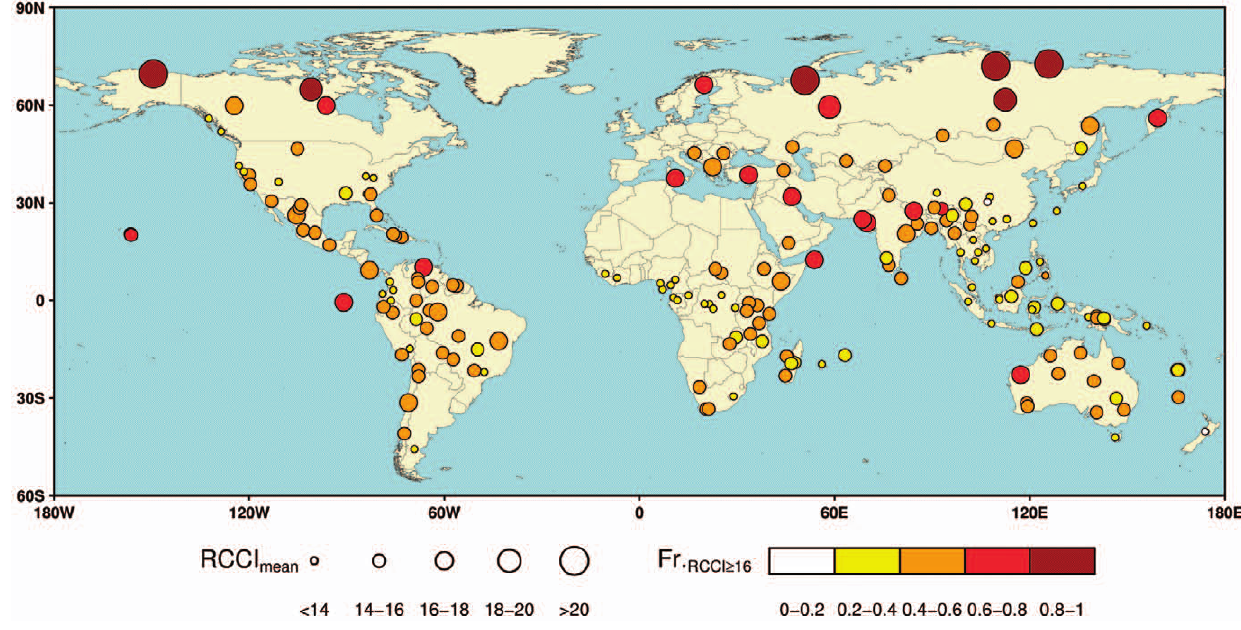
Figure 2. The spatial distributions of Regional Climate Change Index (RCCI) across 196 G200 ecoregions. Based on differences in climate conditions between 1991 2 2010 and 2081 2 2100 generated from the ensemble of 62 GCM 6 GHG emission scenario combinations, the relative climate-change exposure of each G200 ecoregion is indicated by the multi-model mean RCCI (RCCI mean , illustrated as the size of the symbol) and the proportion of GCM 6 GHG emission scenario combinations with RCCI $ 16 (Fr. RCCI $ 16 , illustrated as the color of the symbol).